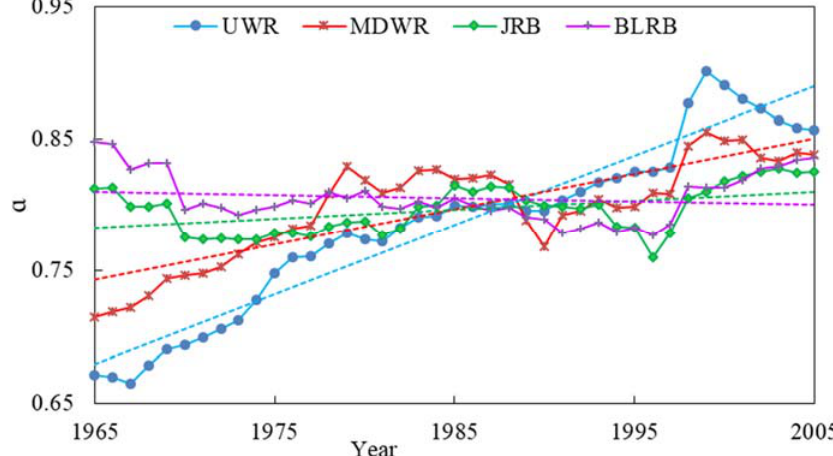
Figure 6. Temporal evolution of the annual parameter α . The solid line and the dotted line refer to the 11-year moving and trend line of parameter α , respectively.